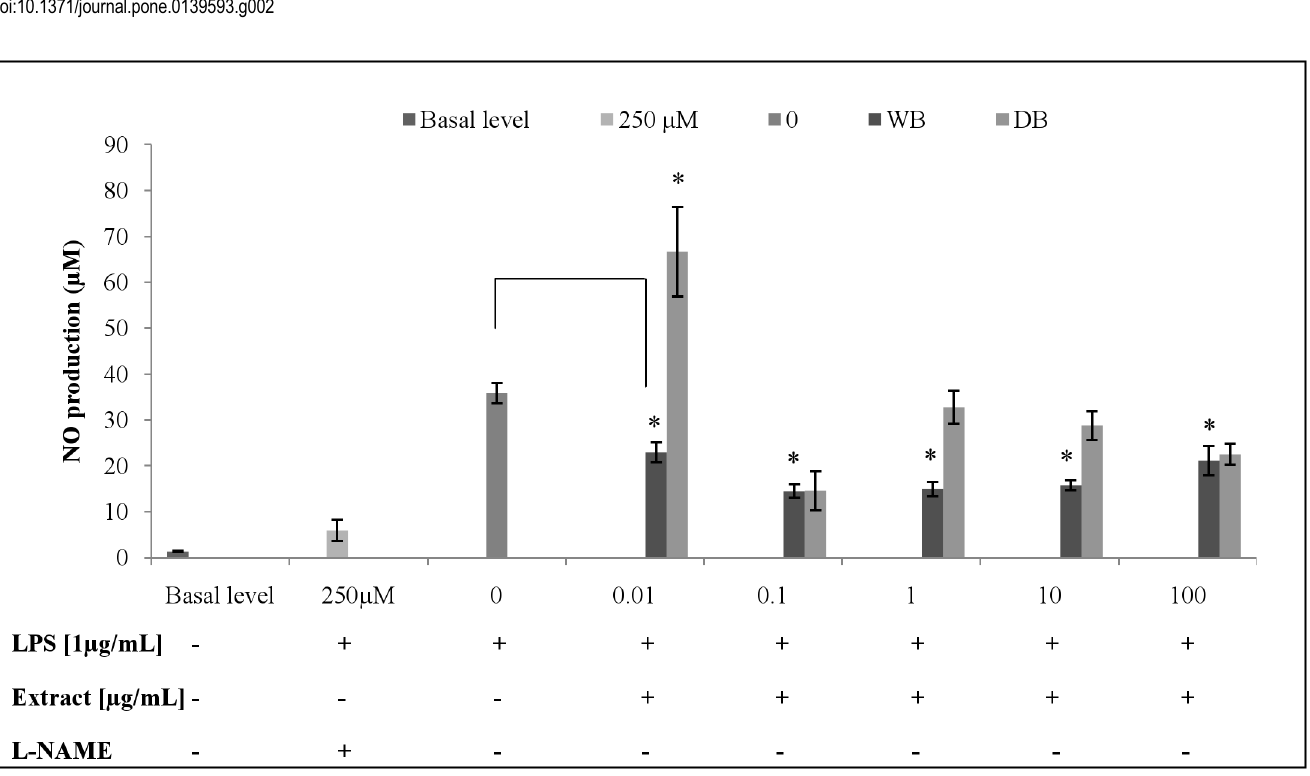
PLOS ONE | DOI:10.1371/journal.pone.0139593 October 1,